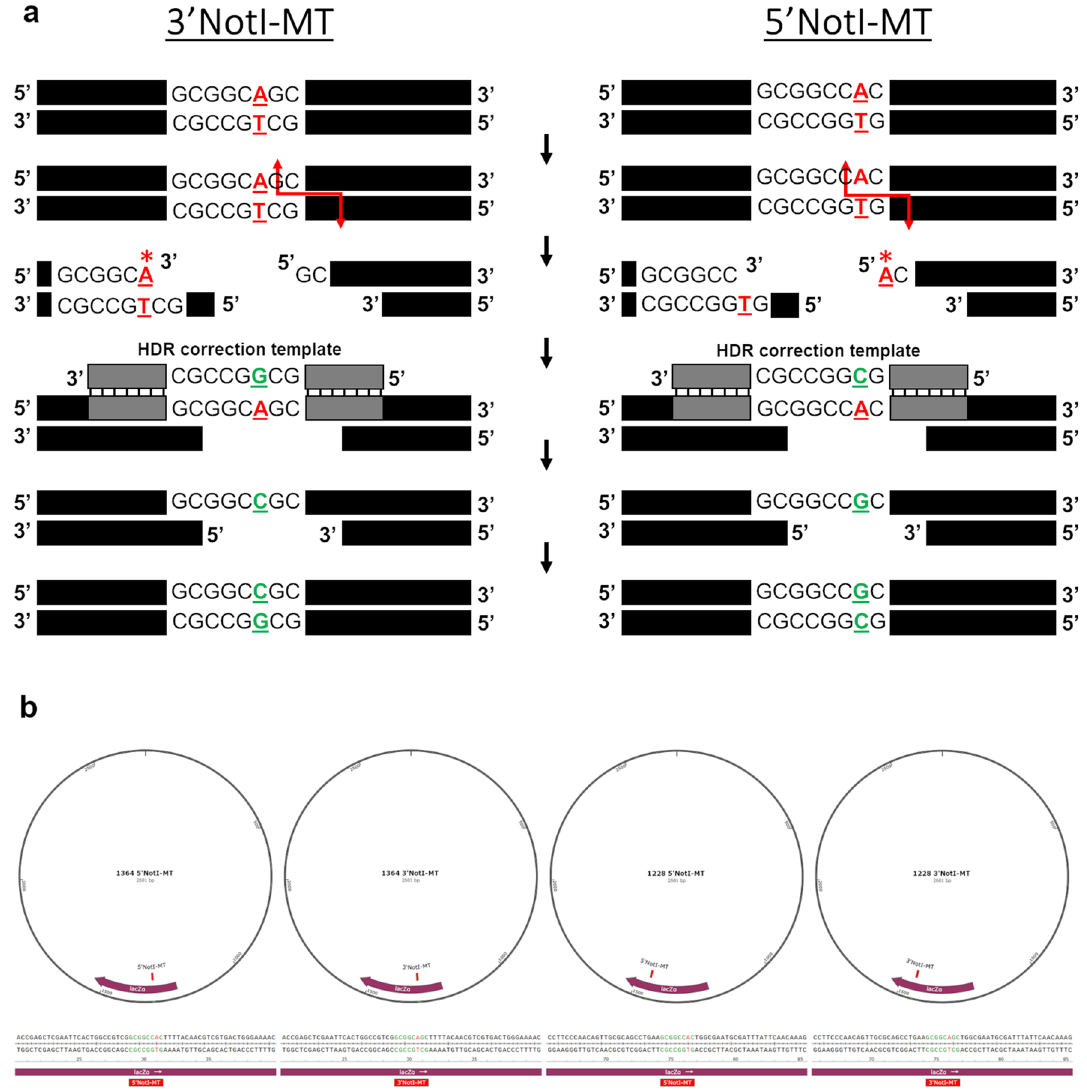
Figure 2. HDC reactions and NotI-MT plasmids. ( a ) Illustrations are shown of the HDC reactions used for the single base point mutation repair of 3 ′ NotI-MT A > C (left) and 5 ′ NotI-MT A > G (right). ( b ) Representations are shown of the four NotI-MT plasmids generated and the unique mutations incorporated, 5 ′ or 3 ′ , at each of the two unique targeted sites, 1364 or